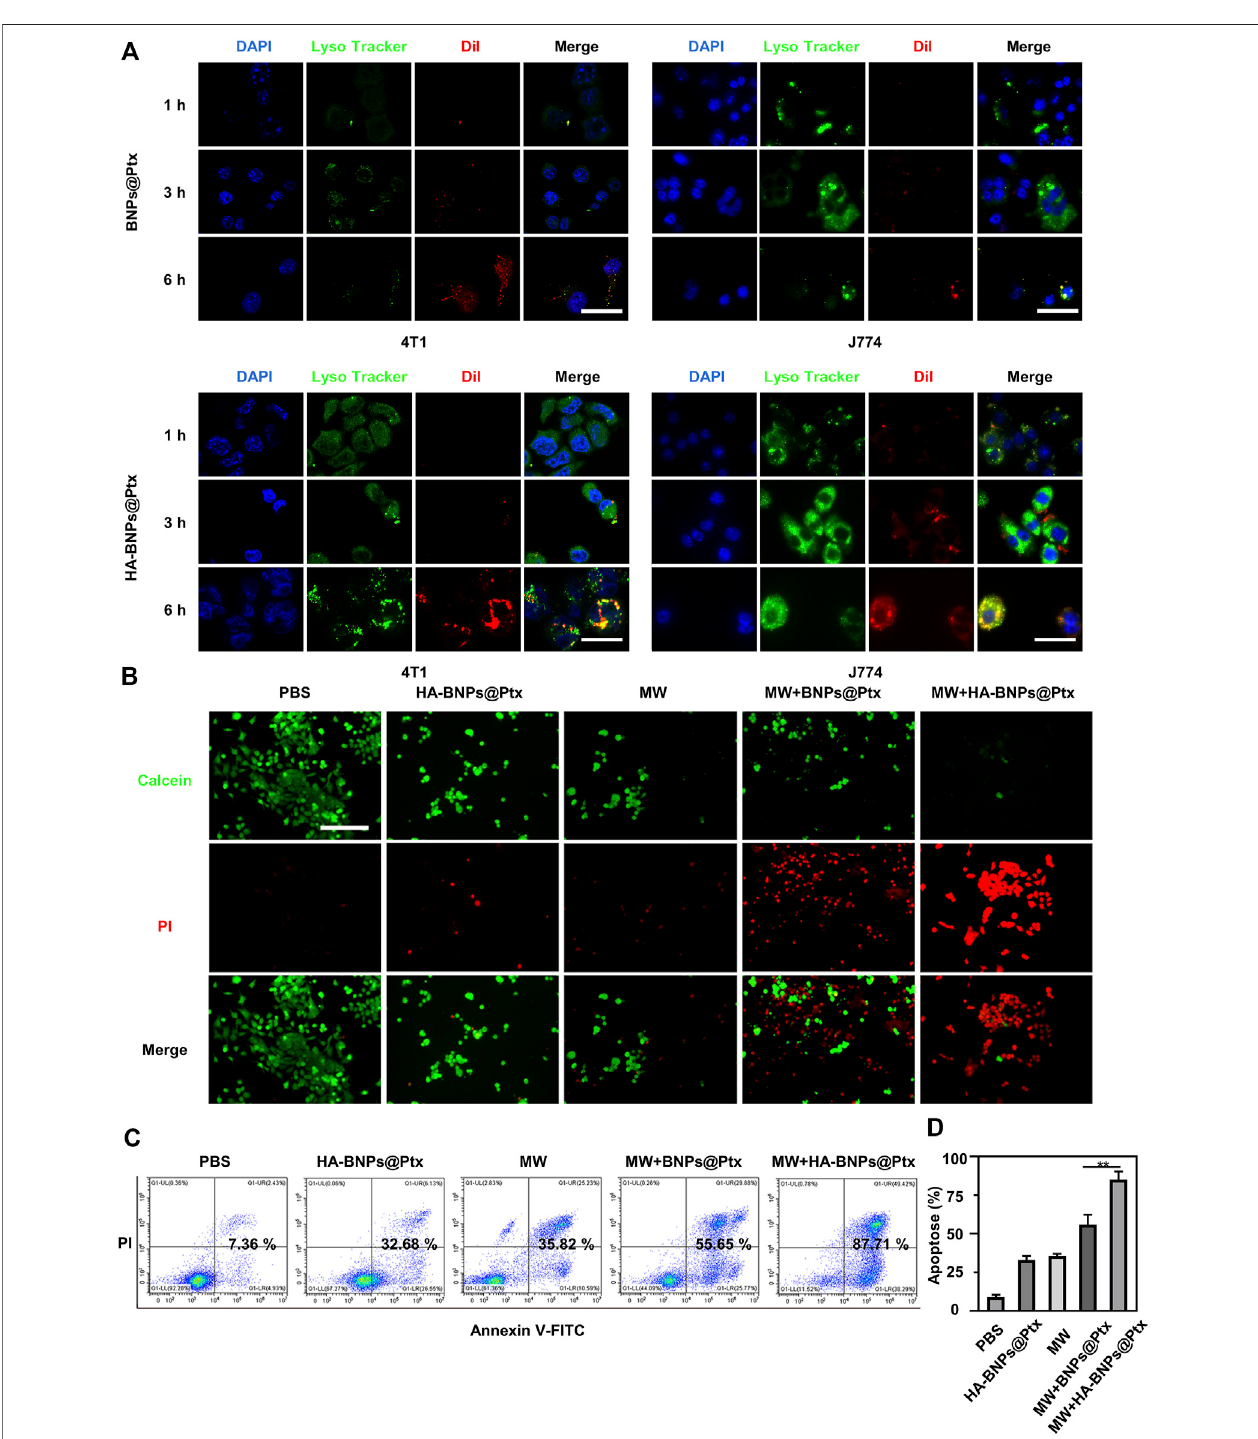
FIGURE 4 | In vitro endocytosis and apoptosis studies. (A) Representative confocal imaging of 4T1 breast cancer cells and J774 macrophages incubated with BNPs@PtxandHA-BNPs@Ptxfor1,3,and6 hat37 ° C.Thecellnucleiwerestainedby4,6-diamidino-2-phenylindole(DAPI)(blue),theendo/lysosomesbyLysoTracker Green (green), and HA-BNPs@Ptx were labeled with DiI (red). Scale bars represent 20 μ m. (B) Fluorescence images of 4T1 cells treated with phosphate buffer saline (PBS), HA-BNPs@Ptx, MW, MW + BNPs@Ptx, or MW + HA-BNPs@Ptx. Live cells were stained by Calcein-AM (green) and dead cells by PI (red). Scale bars represent50 μ m. (C) Aftertreatment,earlyand lateapoptotic cellsweredetermined by fl owcytometry usingtheAnnexin V-AlexaFluor488/PropidiumIodideApoptosis Detection kit. (D) Total cell apoptosis rate was detected by fl ow cytometry. The data are presented as mean ± SD ( n (cid:2) 3, ** p < 0.01).